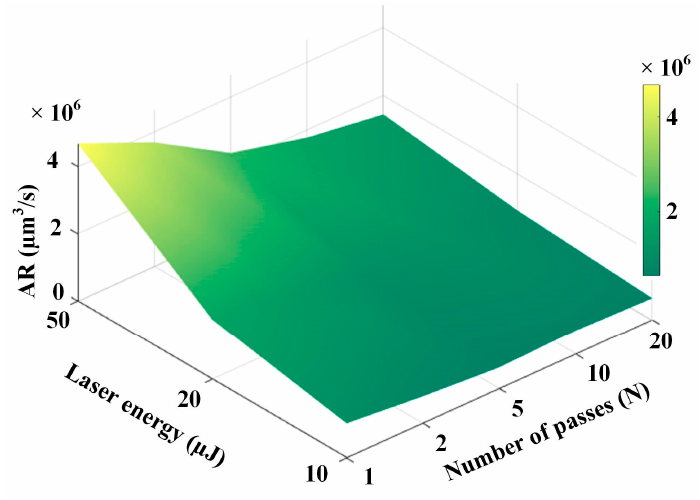
Figure 16. Mapping of AR with the number of passes and laser energy.